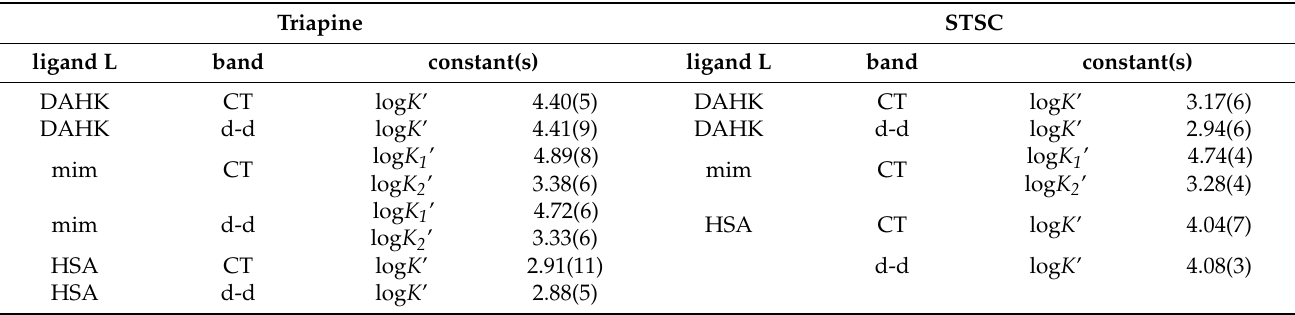
Table 3. Conditional stability constants (log K ’) for the formation of ternary copper(II)-STSC-DAHK/mim/HSA complexes in 30% ( w / w ) DMSO/H 2 O at pH 7.4 (20 mM HEPES) determined by UV–vis spectrophotometric measurements. In systems of DAHK and HSA 4 h, while with min only 5 min equilibration time was applied. Uncertainties (SD) of the last digits are in parenthesis. { T = 25 ◦ C; I = 0.10 M (KCl)}. Triapine